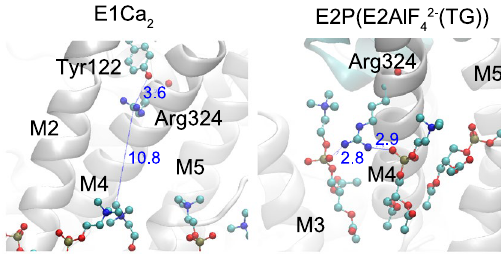
Figure 1. Protein-phospholipid interaction observed in crystal structures. Residue Arg324 and neighboring phospholipids in E1Ca 2 (PDB ID: 5XA7) and an E2P analog (E2AlF 42− (TG); PDB ID: 5XA9) are shown in ball and stick models. Residue Tyr122 is also shown in the E1Ca 2 structure. The distance between Arg324 and the phosphate moiety is larger than 10 Å in E1Ca 2 . Protein-phospholipid interactions between Arg324 and the phosphate groups of phosphatidylcholines observed in the E2P analog are indicated by blue dotted lines. The distances (Å) are indicated by blue